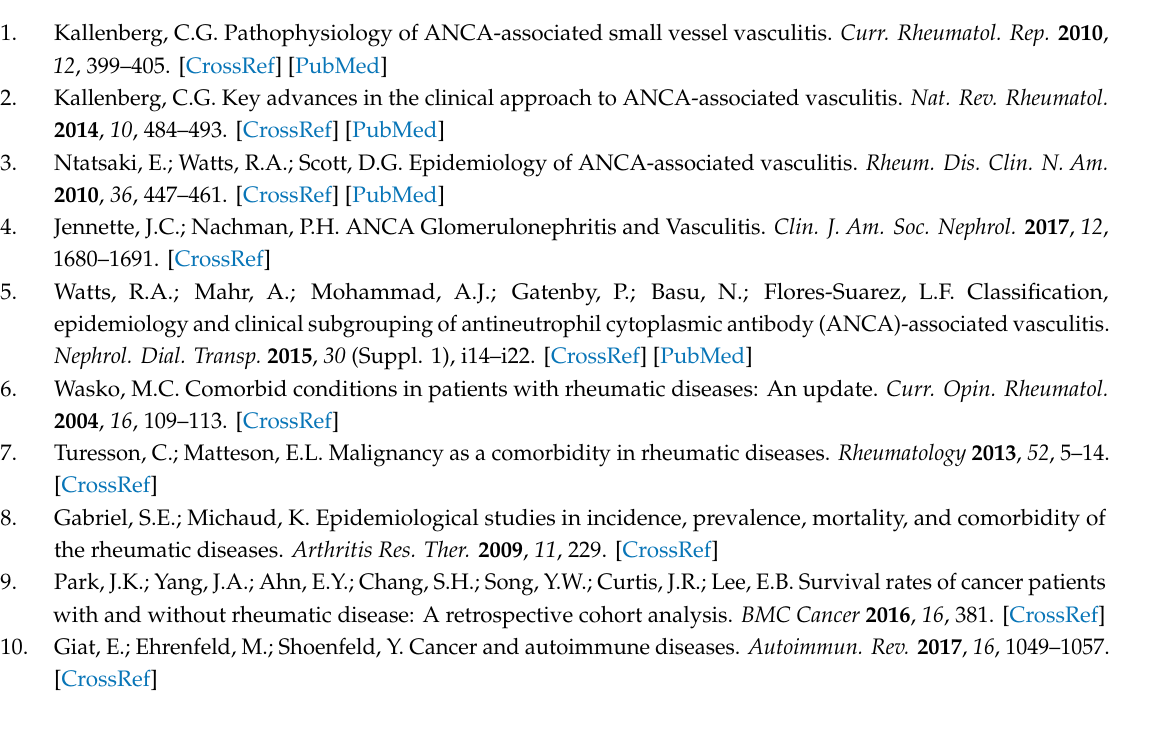
Supplementary Figure S1. Flowchart for patient selection; Supplementary Table S1. Cancer-specific risk based on the use of cyclophosphamide and rituximab in patients with AAV; Supplementary Table S2. Cancer-specific risk based on the use of azathioprine / mizoribine and methotrexate in patients with